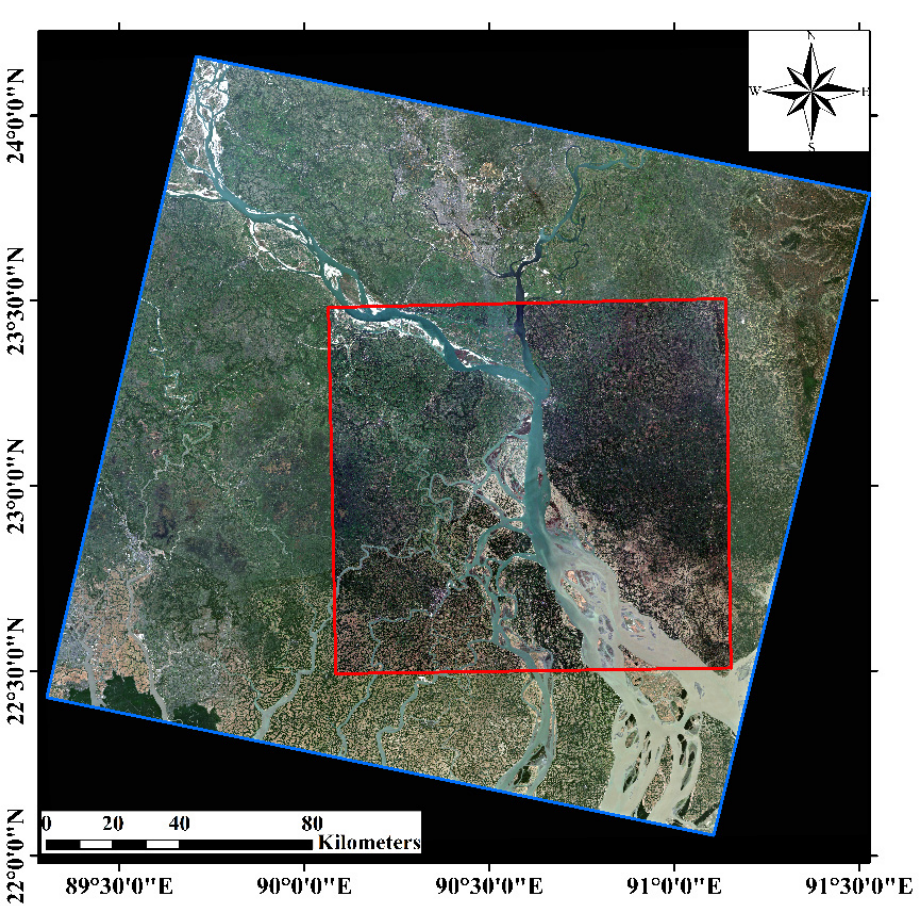
Figure 3. Location of the areas in the Landsat and Sentinel images (the image with a red border is the Sentinel image, and the image with a blue border is the Landsat image).